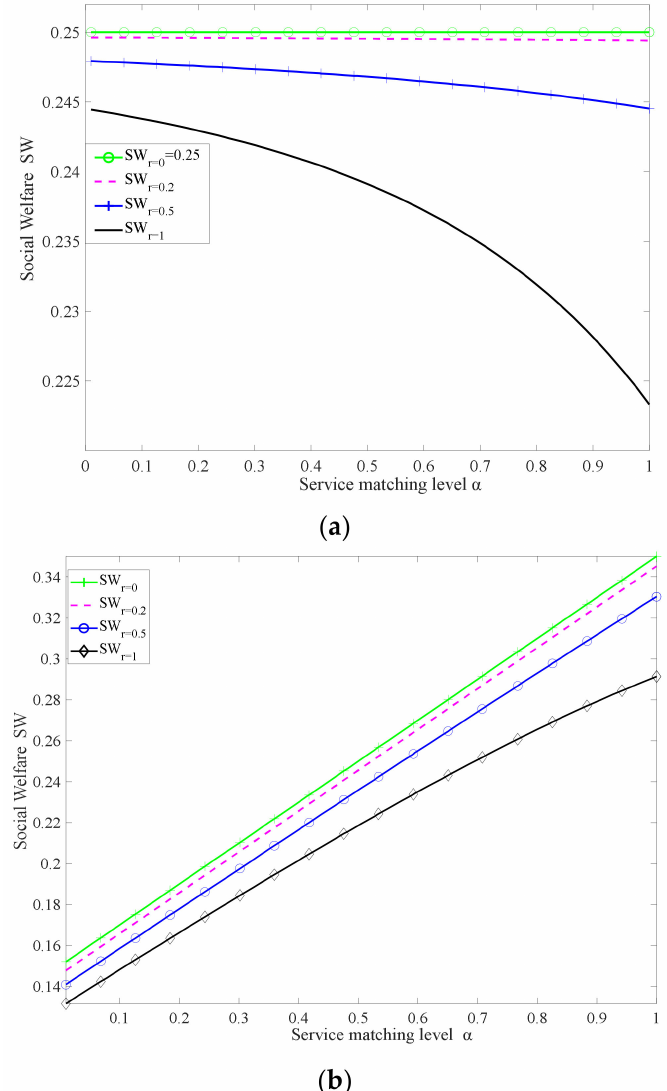
Figure 9. ( a ) The impact of matching rate on social welfare at different commission rates (without consumer privacy benefits). ( b ) The impact of matching level on social welfare at different commission rates (with consumer privacy